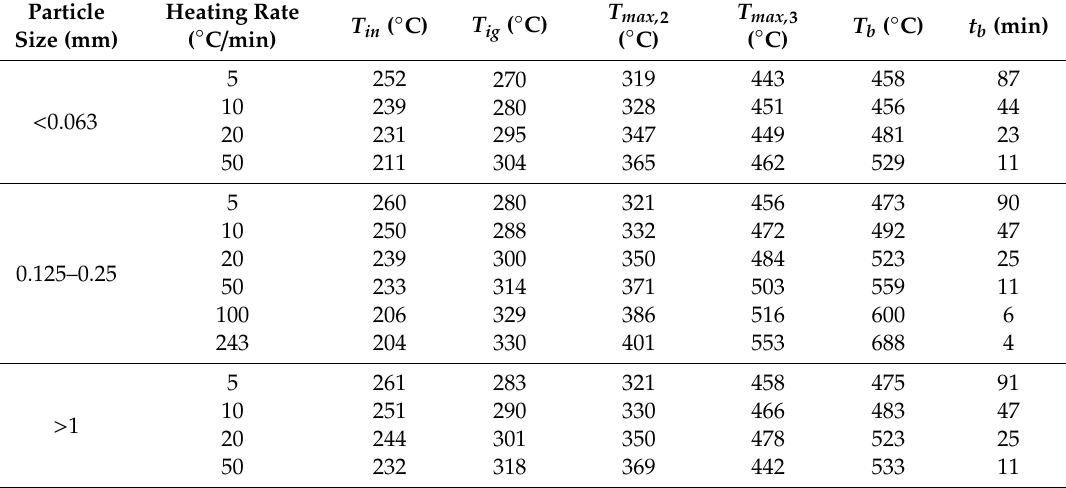
Table 3. Characteristic parameters obtained from the DTG and heat flow curves.